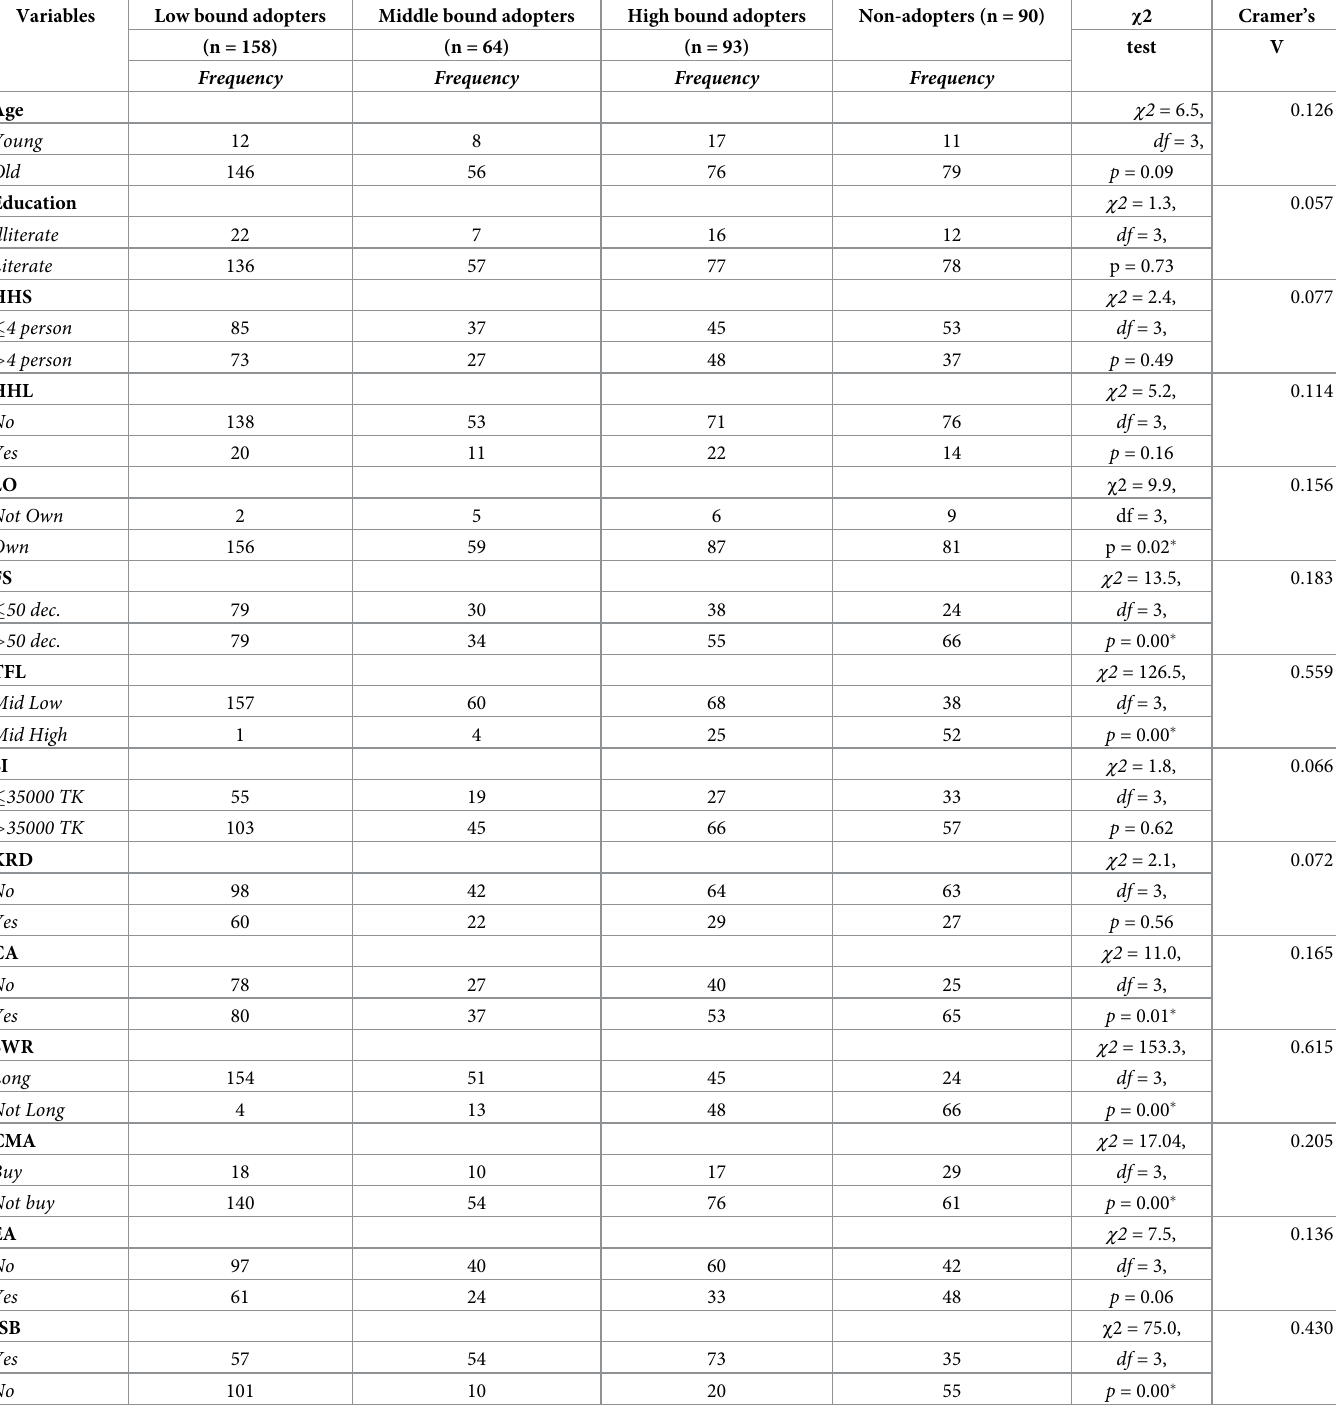
Table 2. Descriptive statistics of the explanatory